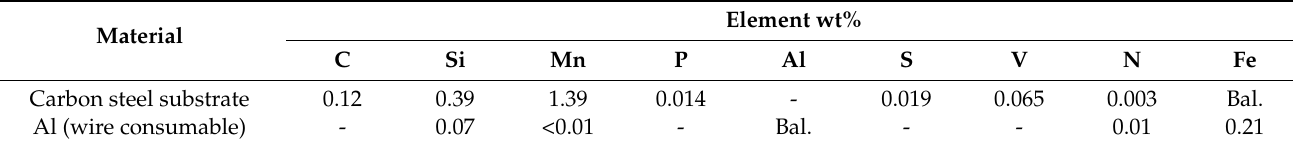
Table 1. Composition of substrate and wire